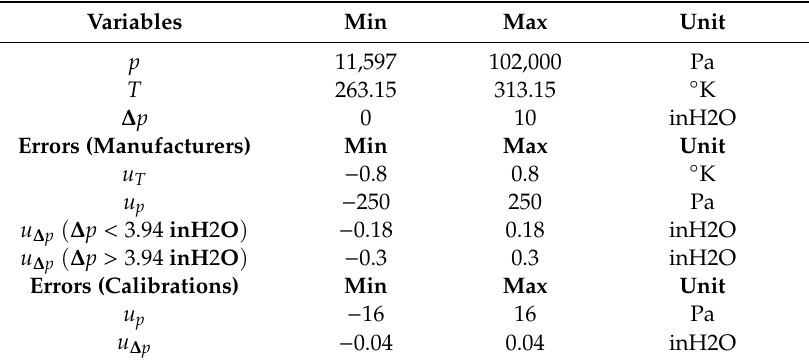
Table 7. Input variables and respective